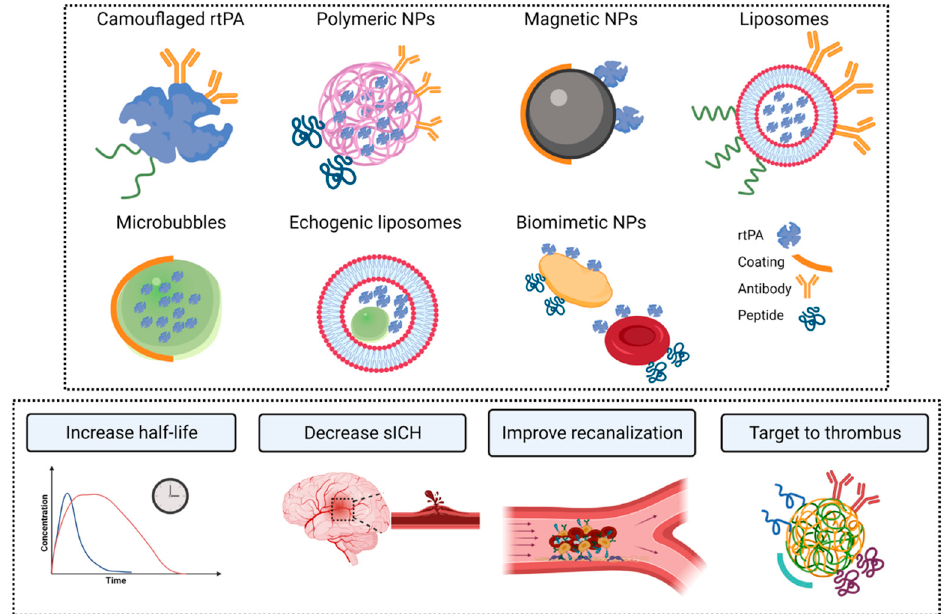
Figure 5. Examples of nanodelivery systems for rtPA to extend the half-life of the therapeutic agent, to reduce secondary effects, improve the recanalization, target the therapy, and improve the efficacy. Figure created with